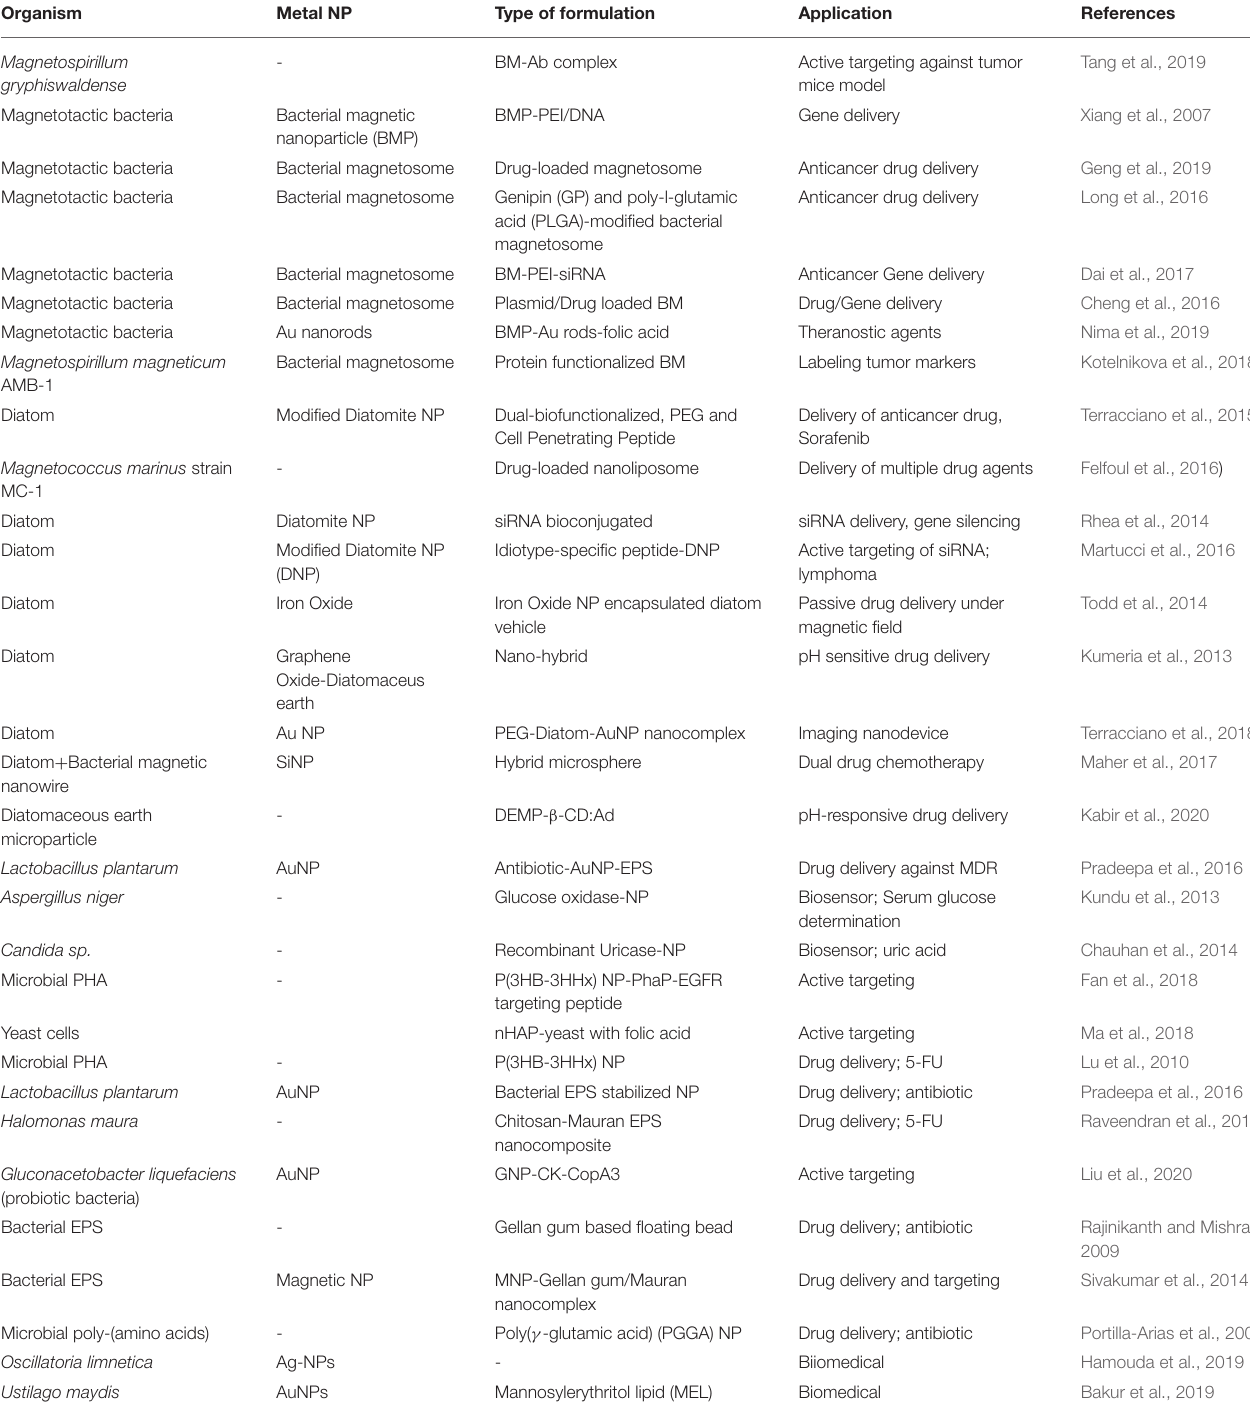
TABLE 1 | Summary of microbial fabricated nanomaterials for drug delivery